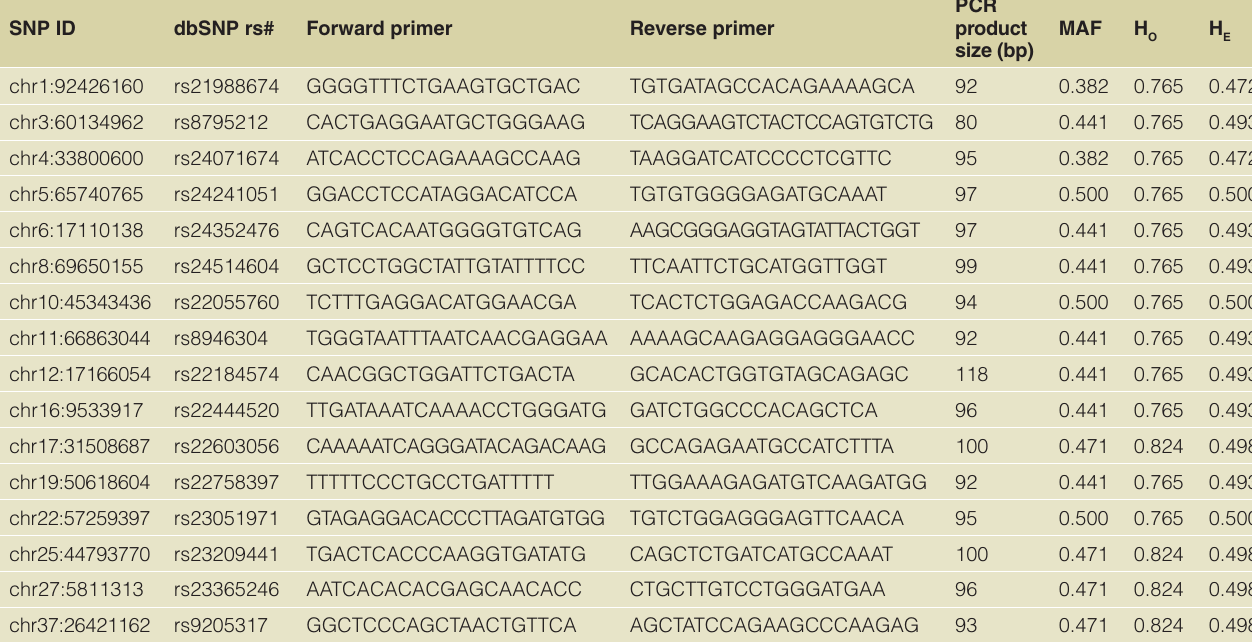
Table 1. Sixteen single nucleotide polymorphisms (SNPs) and their primer pairs for high-resolution melt curve genotyping assay. SNP ID chromosomal coordinates and dbSNP rs numbers correspond to the CanFam2 dog genome assembly. Measures of genetic variability correspond to the initial seventeen northeastern and Ohio coyotes ( Canis latrans ) that formed the ascertainment pane l.